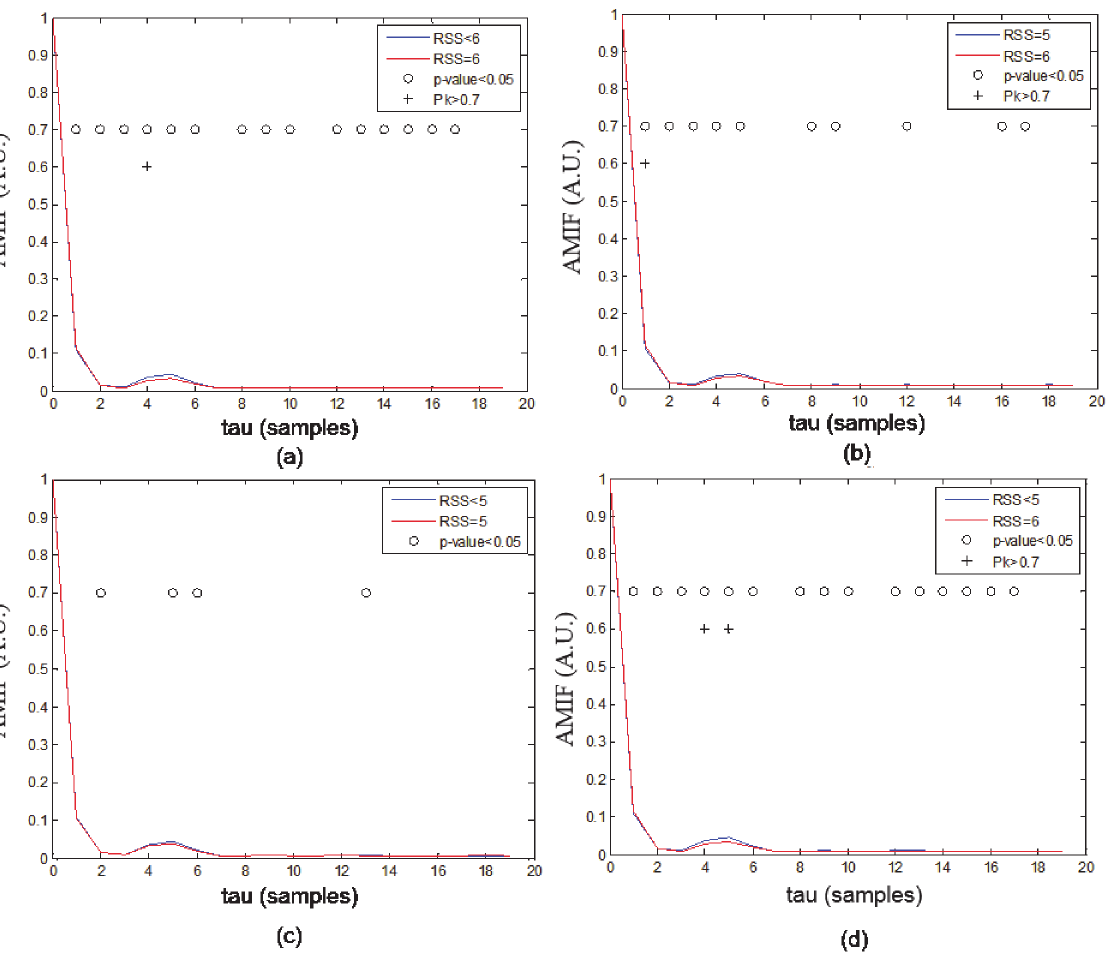
Fig 1. Auto-Mutual Information Function (AMIF). Averaged AMIF functions in VHF (105 – 145 Hz) band q = 0.5 of all windows of (a) RSS < 6 and RSS = 6, (b) RSS = 5 and RSS = 6, (c) RSS < 5 and RSS = 5, (d) RSS < 5 and RSS = 6. The p-values were corrected using Bonferroni